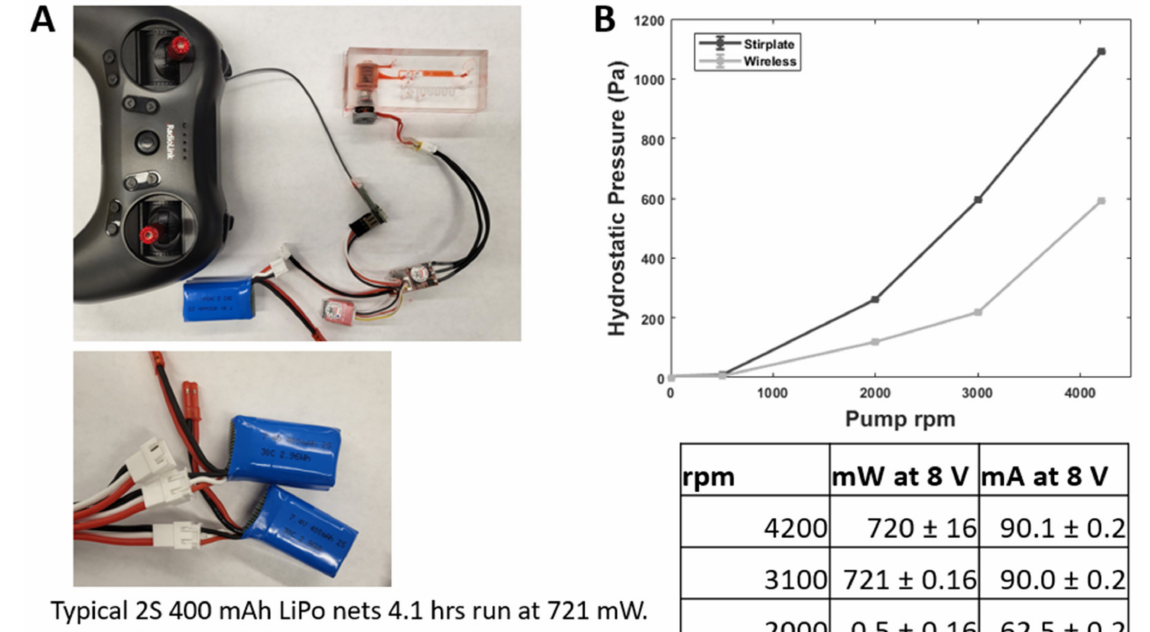
Figure 8. Wireless operation of Integrated µ Tesla Pump. ( A ) Wireless operation was enabled by inserting a miniature quadcopter brushless motor into the device and powering it using a micro speed controller and RF receiver. The speed was controlled by the RF joystick (on the transmitter) and monitored via a Bluetooth app on a smartphone not pictured. ( B ) The pump output under wireless operation was lower than the output when driven by a laboratory stir plate. The difference was attributed to brushless motor cogging below its designed speeds, which prevented steady µ Tesla rotations. The table summarized the power consumption of the wireless operation of the µ Tesla pump. At a maximum of 4000 rpm, the power draw was 721 mW. With multiple LiPo batteries in parallel, the run time can be extended